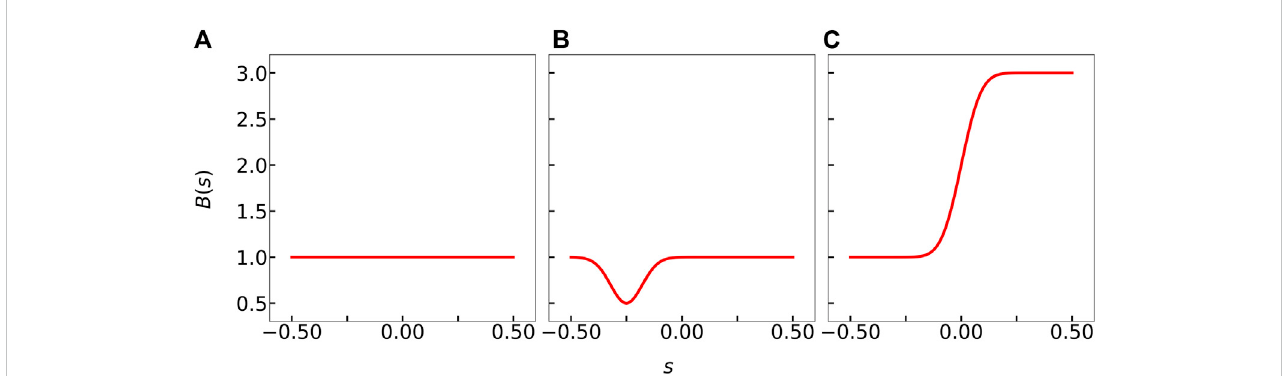
FIGURE 1 Rigidity pro fi les examined in this work. (A) Constant rigidity B 1 ( s ). (B) Locally weak stiffness pro fi le B 2 ( s ) to re fl ect structural degradation due to protein attachment. (C) Asymmetricallyrigid stiffness pro fi le B 3 ( s ) to re fl ect higher resistance to bending due toselectiveproteinattachmentone-half ofthe fi